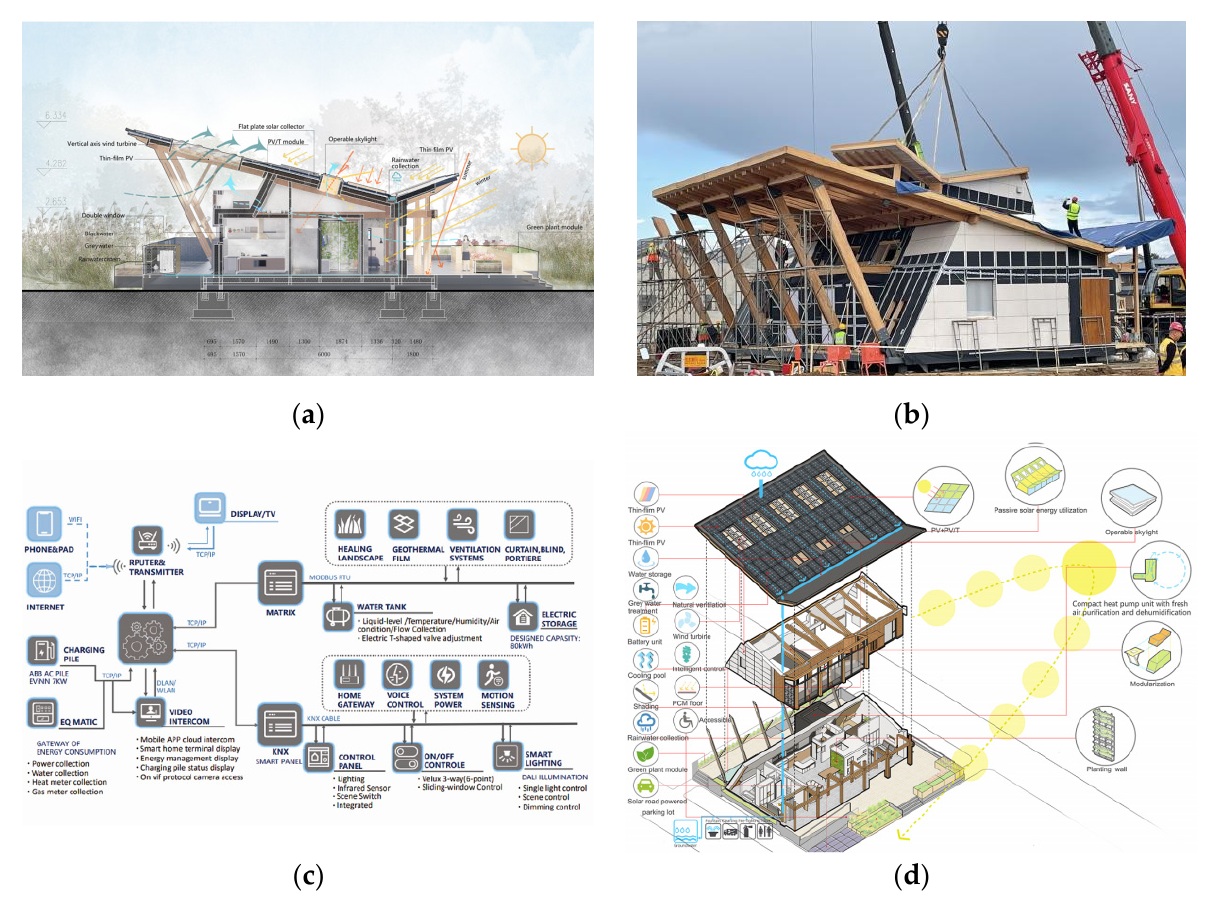
Figure 11. Main results of R-CELLS. ( a ) Close-to-nature design. ( b ) Prefabricated modules. ( c ) Intelligent systems. ( d ) Energy integration technologies.